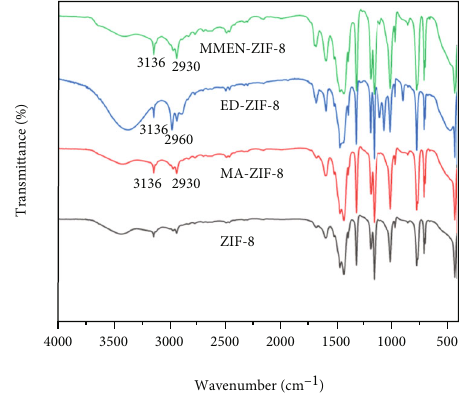
Figure 4: FTIR spectra of MA-ZIF-8, ED-ZIF-8, and MMEN-ZIF-